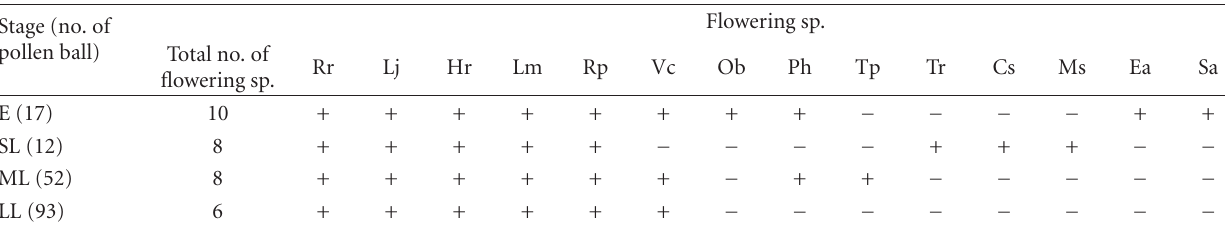
Table 2: Species of pollen grains contained in cells for each developmental stage collected on 1 July. +: present; − : absent; LL: large larva; ML: medium larva; SL: small larva; E: egg. Sum of set 69 nests and sampled 10 nests for determination of developmental period, was shown in this table. Stage (no.